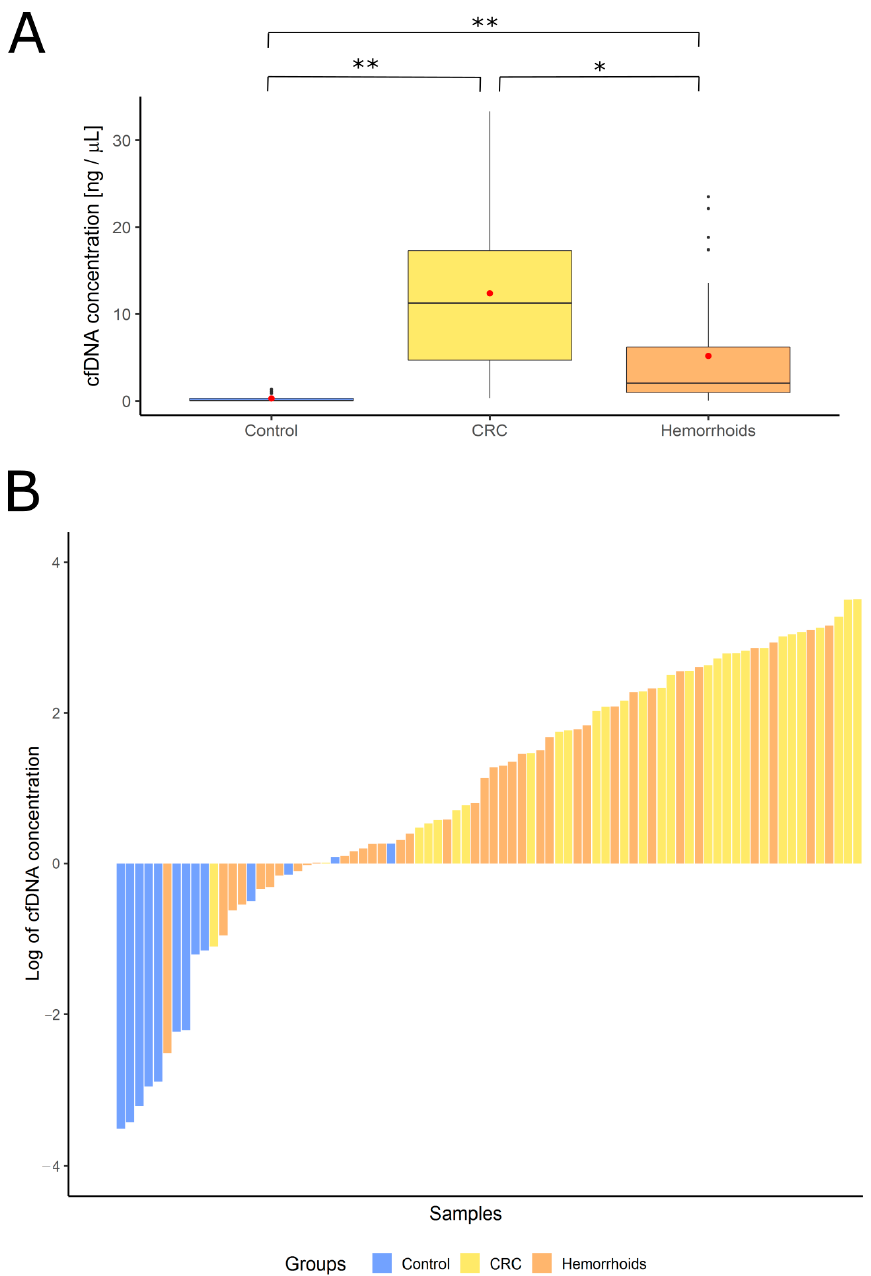
Figure 3. The concentration of cell-free DNA in different groups of patients. ( A ) Concentra- tion ranges represented with box plots—red dots represent average values in each group (healthy controls 0.29 ng/ µ L, colorectal cancer patients 12.36 ng/ µ L and hemorrhoid pa- tients 5.17 ng/ µ L). Statistical significance was calculated with t -test (* p < 0.05, ** p < 0.001). ( B ) Distribution of cfDNA concentration from lowest to the most concentrated sample based on the origin of the sample. Control—healthy controls, CRC—colorectal cancer patients, Hemorrhoids—patients with